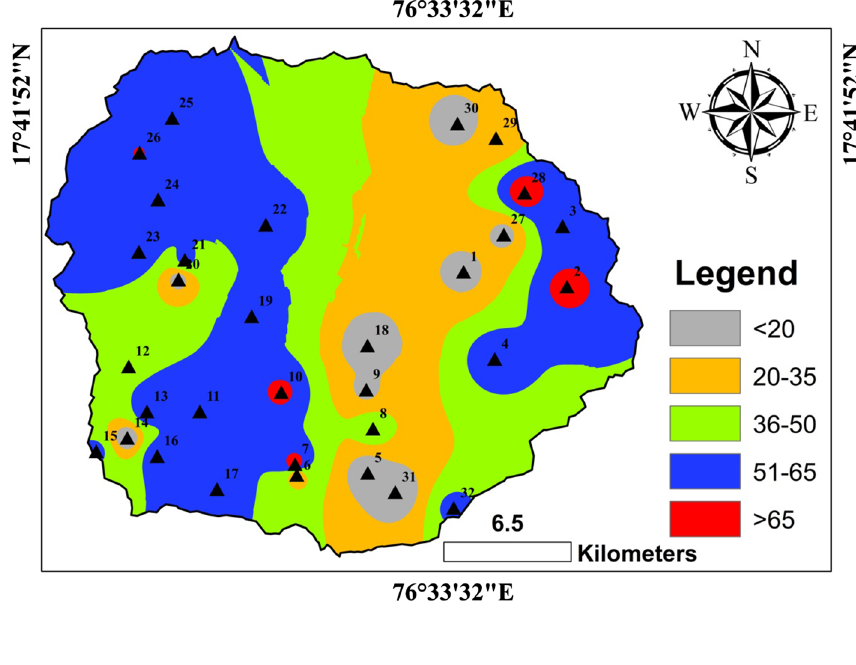
Fig. 27 Geospatial distribution of nitrate